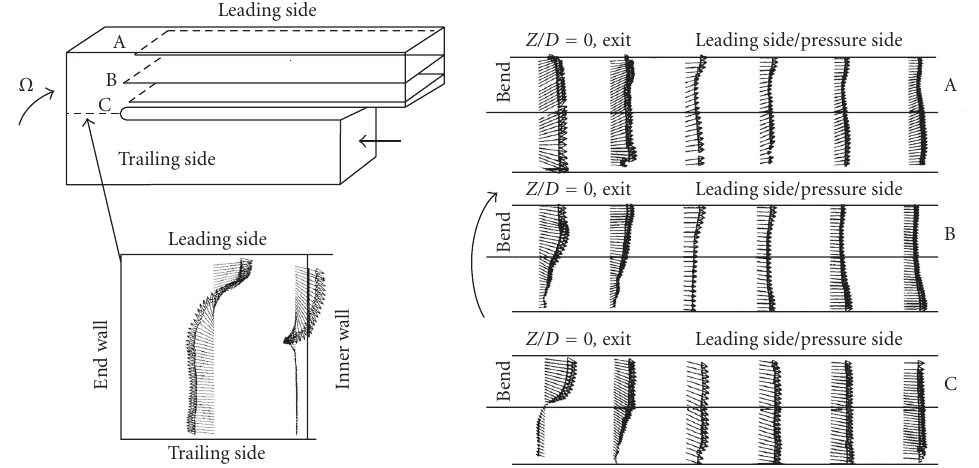
Figure 2: Measured flow development (see Iacovides et al.